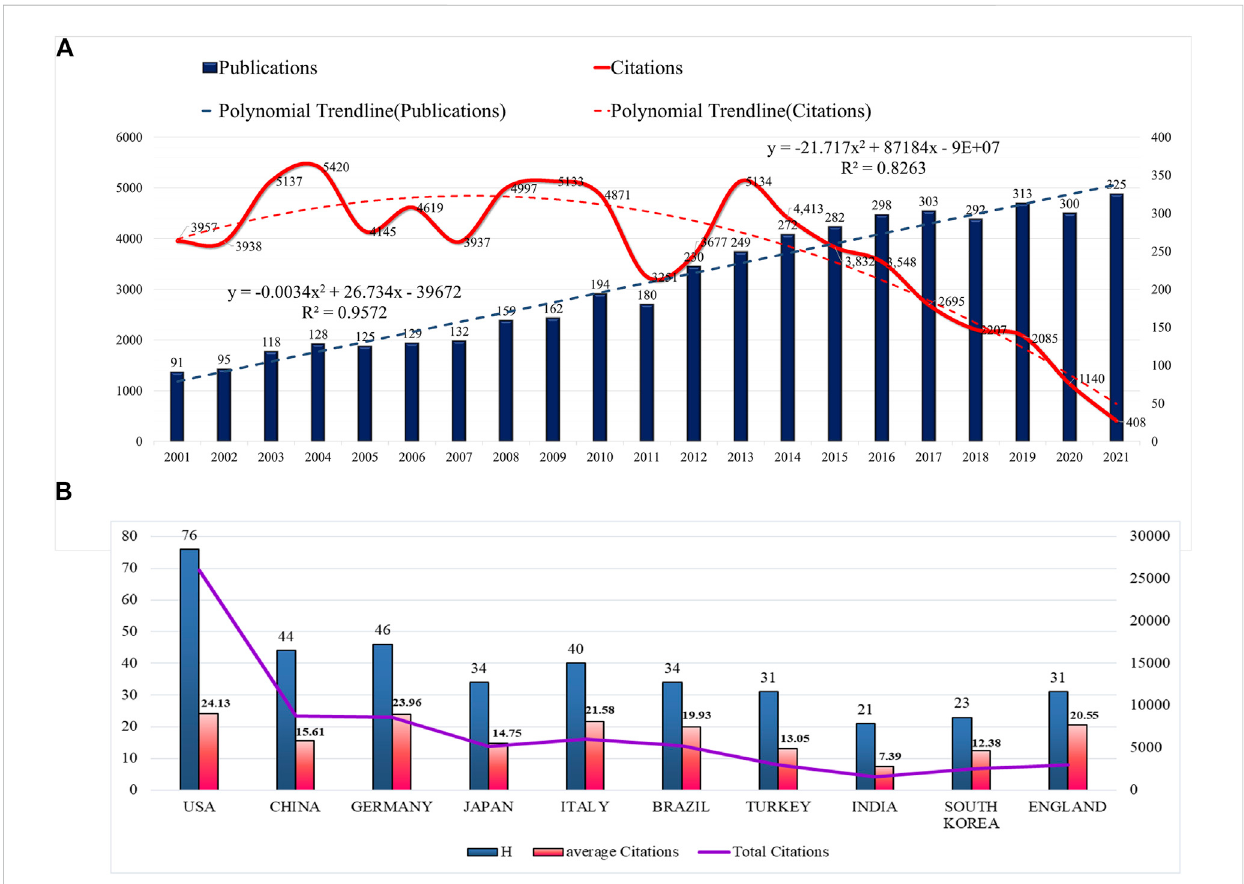
FIGURE 2 Trends in publications and citations of mandibular defect research. (A) The annual trends of global publications and citations. (B) H-index, average citations (citations per article), and total citations of the top ten countries.